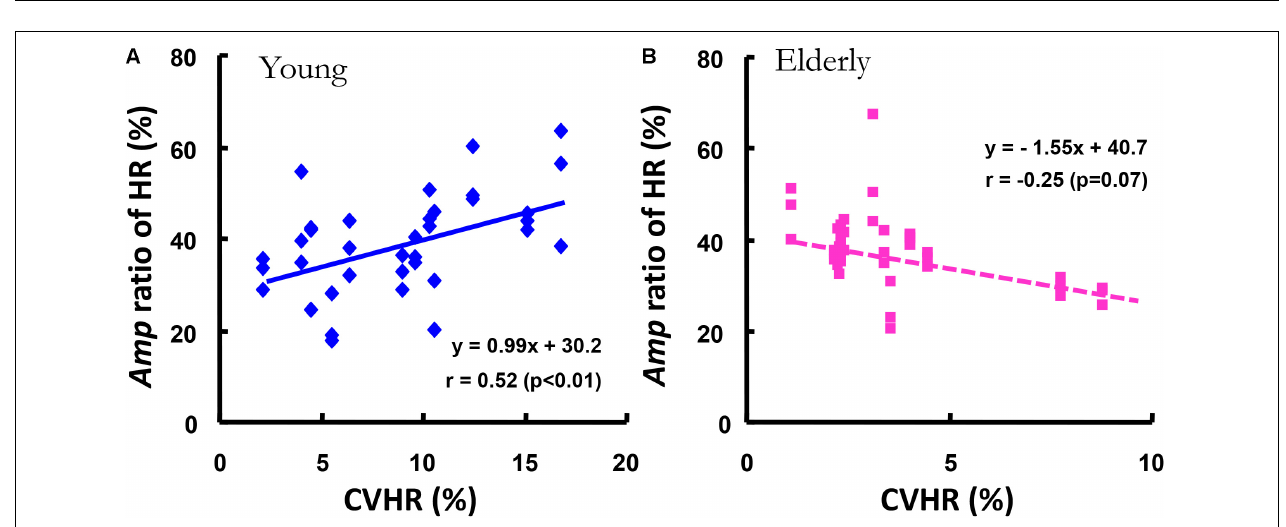
FIGURE 6 | The relationship between the Amp ratio of the HR kinetics and the covariance of variance of HR during standing (CVHR). The Amp ratio of the HR kinetics was significantly related to the CVHR in the YG ( r = 0.52, p < 0.01, A ), but not in the ELD (B) .